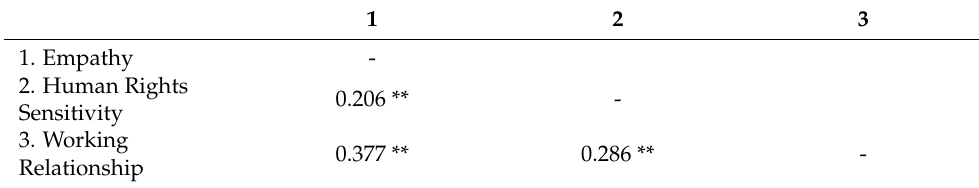
Table 3. Correlations among the study